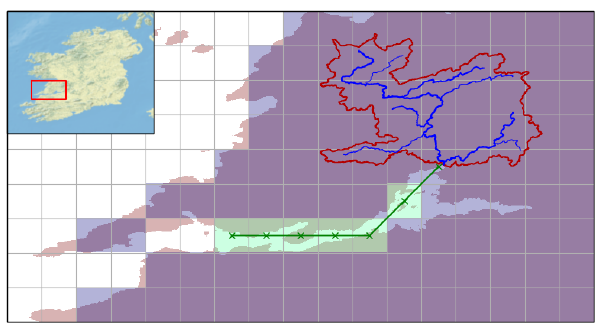
Figure 1. Example of an estuary opening: the red mask is the HR land mask, the blue mask is the 12D land mask, and the green mask represents the 12D cells converted from land to ocean to connect the river basin delineated in red to the ocean.